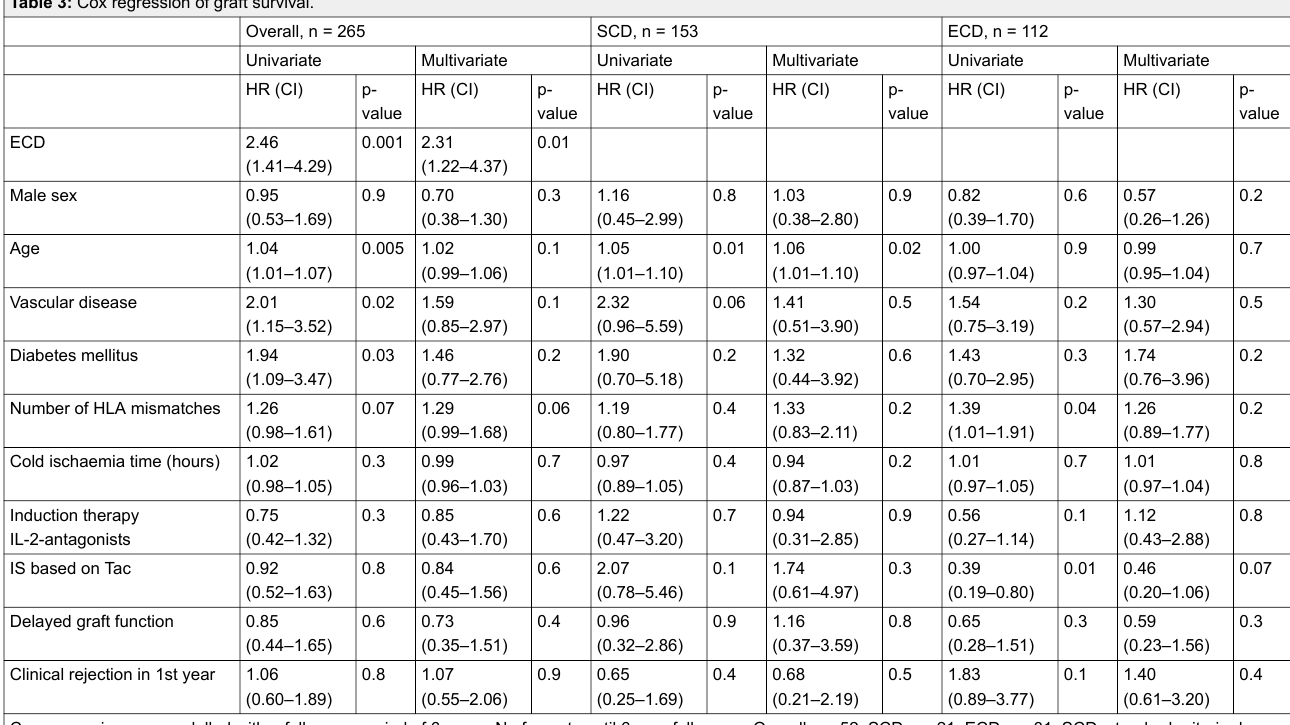
Table 3: Cox regression of graft survival.